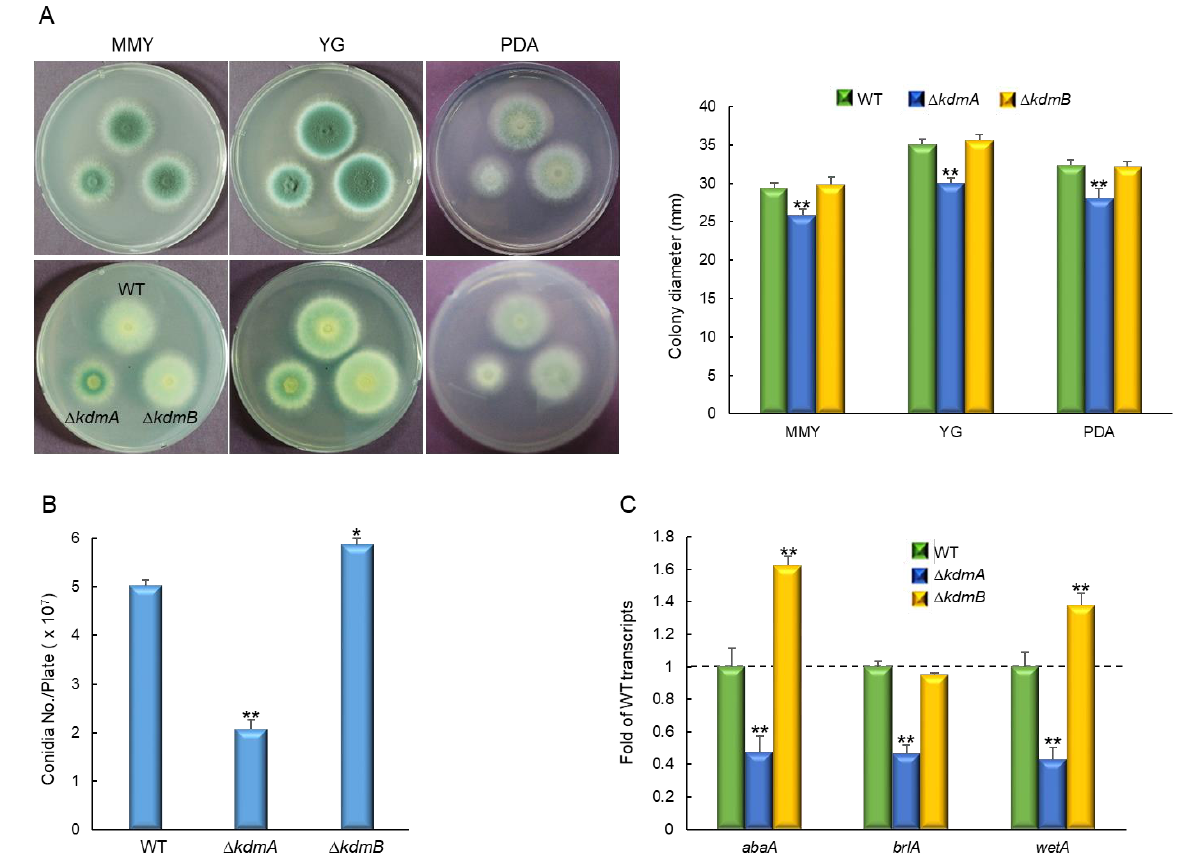
Figure 2. KdmA and KdmB regulate normal growth and asexual development in different ways. ( A ) Colony photographs and growth of WT, ∆ kdmA , and ∆ kdmB strains point-inoculated on various solid media and grown in solid glucose minimal medium with 0.1% yeast extract (MMY), 10 g/L yeast extract + 30 g/L glucose (YG), or potato dextrose agar (PDA) for 3 days and determined colony diameter. ( B ) Conidia numbers produced by each strain per plate. ( C ) Transcript levels of the key asexual developmental regulators in the mutants relative to the corresponding level in the WT strain at 3 days determined by quantitative RT-PCR (RT-qPCR). Dot line indicates the level of WT transcript. Fungal cultures were grown in MMY, and mRNA levels were normalized to the expression level of the ef1 α gene. Statistical significance of differences was assessed by Student’s t -test: * p < 0.05, ** p <